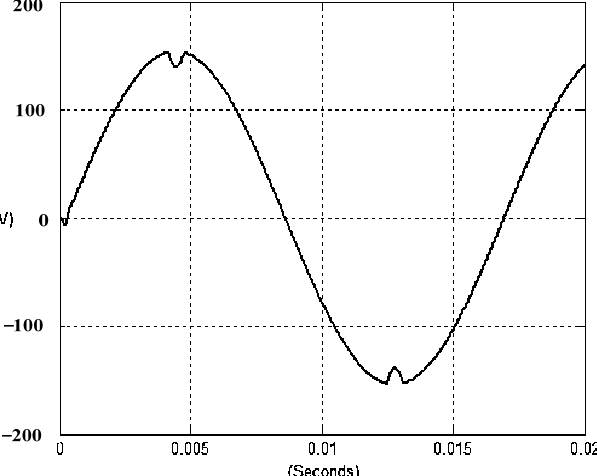
Figure 6. Simulated AC output voltage for the proposed method under a sudden increment of load.